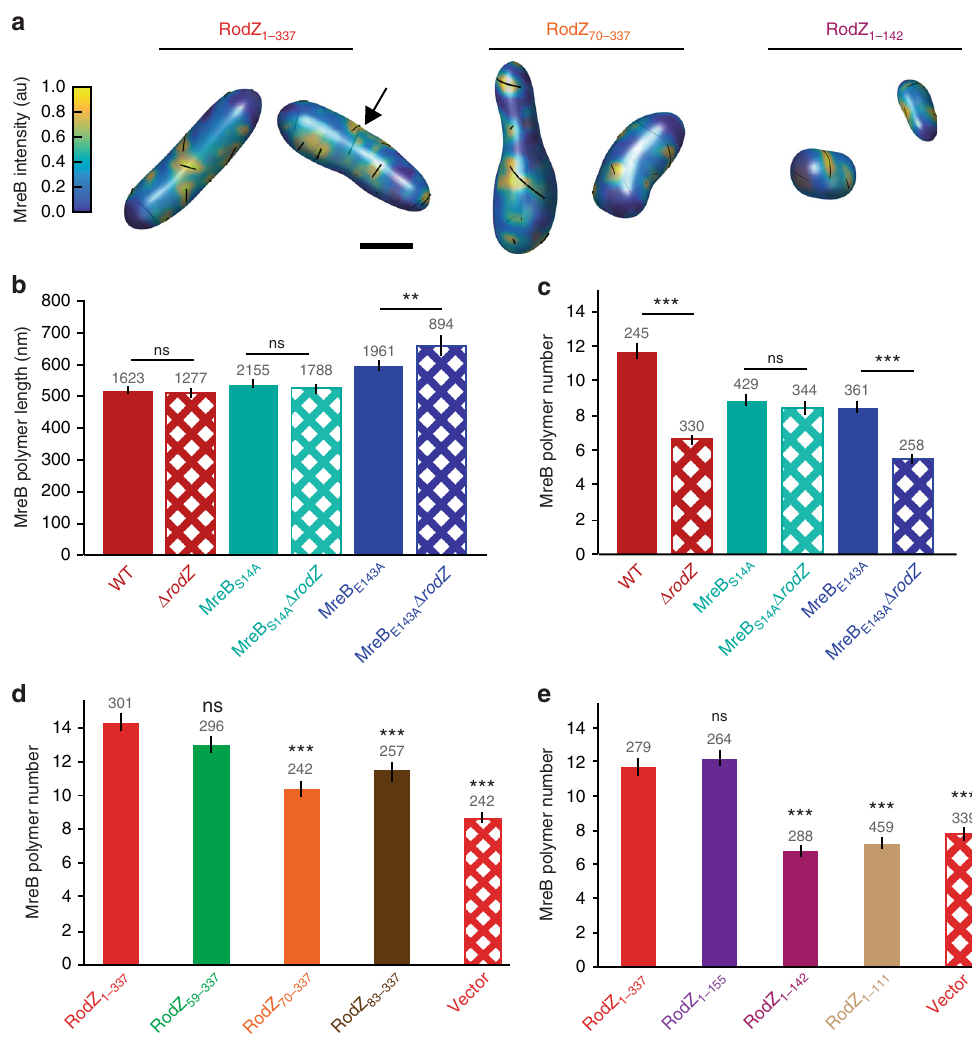
Fig. 3 RodZ acts as an MreB assembly factor. a Semi-transparent 3D renderings of cells with full-length or truncated RodZ as indicated. MreB polymers are indicated with black lines and may be present on the back of the cell where they appear less vividly black (see example at arrow). b The average MreB polymer length (>200 nm) per cell in different MreB point mutants in the presence and absence of rodZ . c The average MreB polymer number per cell in different MreB point mutants in the presence and absence of rodZ . b , c p -value from Student ’ s t- test comparisons are made between strains with similar MreB point mutations. For additional cross-comparisons see Supplementary Table 3. d The average MreB polymer number per cell in RodZ cytoplasmic truncation mutants. e The average MreB polymer number per cell in RodZ periplasmic truncation mutants. b – e These experiments were performed on three separate days and the data were pooled. p -value from Student ’ s t- test comparisons are made between indicated strain and a strain with full length RodZ (solid red bar). For other comparisons see Supplementary Table 3. The number above the bars is the number of polymers ( b ) and the number of cells ( c – e ) analyzed. Error bars represent 95% con fi dence intervals. ns p > 0.05, ** p ≤ 0.01, *** p ≤